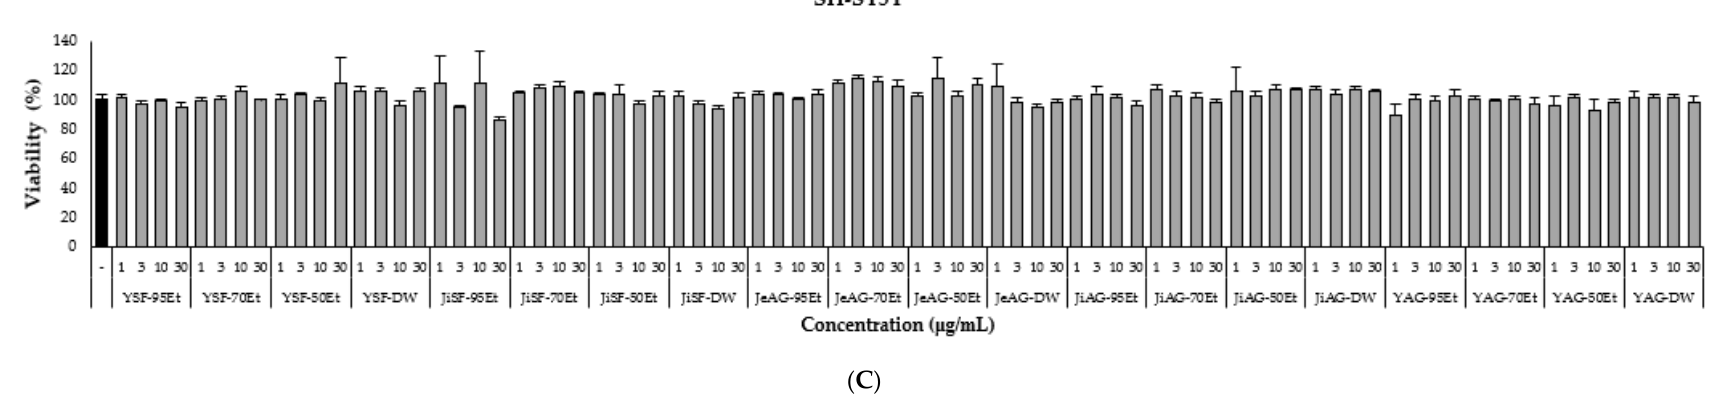
Figure 7. Effect of the extracts on the viability of three cell lines of MDCK ( A ), HL-60 ( B ), and SH-SY5Y ( C ). The cells were treated with the extracts (1, 3, 10, and 30 μg/mL) for 24 h. Culture supernatants were removed, and cell counting kit -8 (CCK-8) was applied. Viability was quantified using the micro plate reader. Data are presented as mean ± SD from three independent experiments.